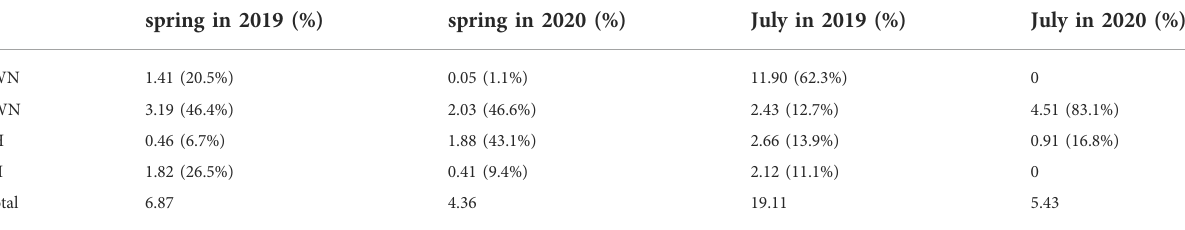
TABLE1Thedailypositiveanomaliesofsurface fl uxesinthespring(MaytoJune)andJulyof2019and2020.All fi eldsareaveragedoverthestudyarea and over the selected time periods (units: W × m − 2